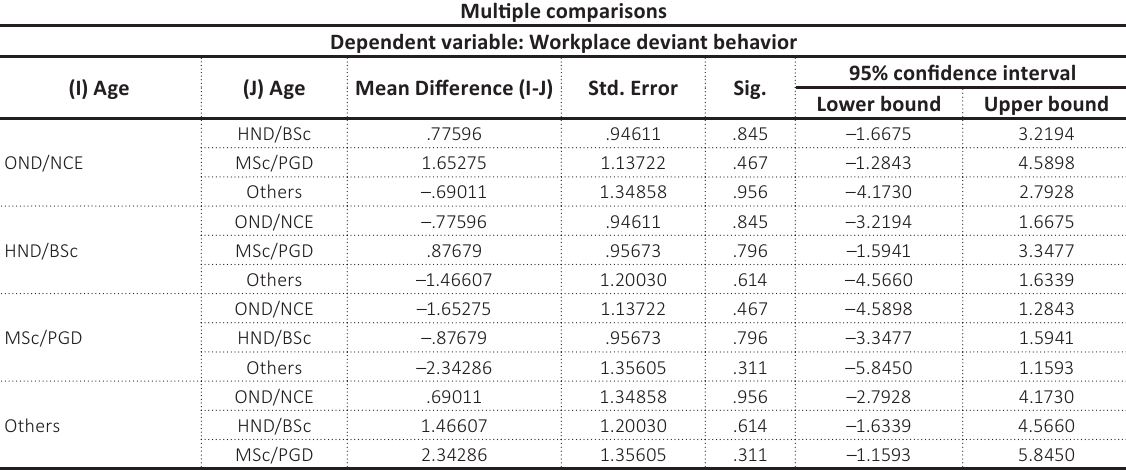
Table 5. One-way ANOVA – multiple comparisons (level of education